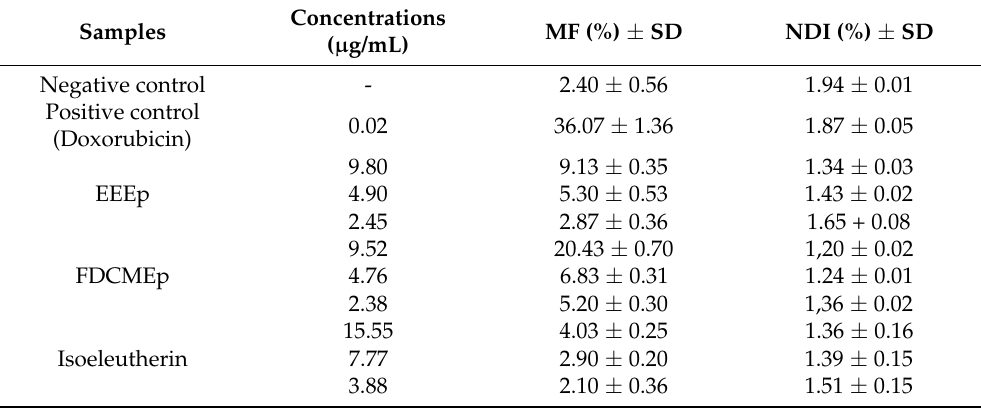
Table 1. Micronucleus frequency (MF) and nuclear division index (NDI) caused by E. plicata samples in HepG2